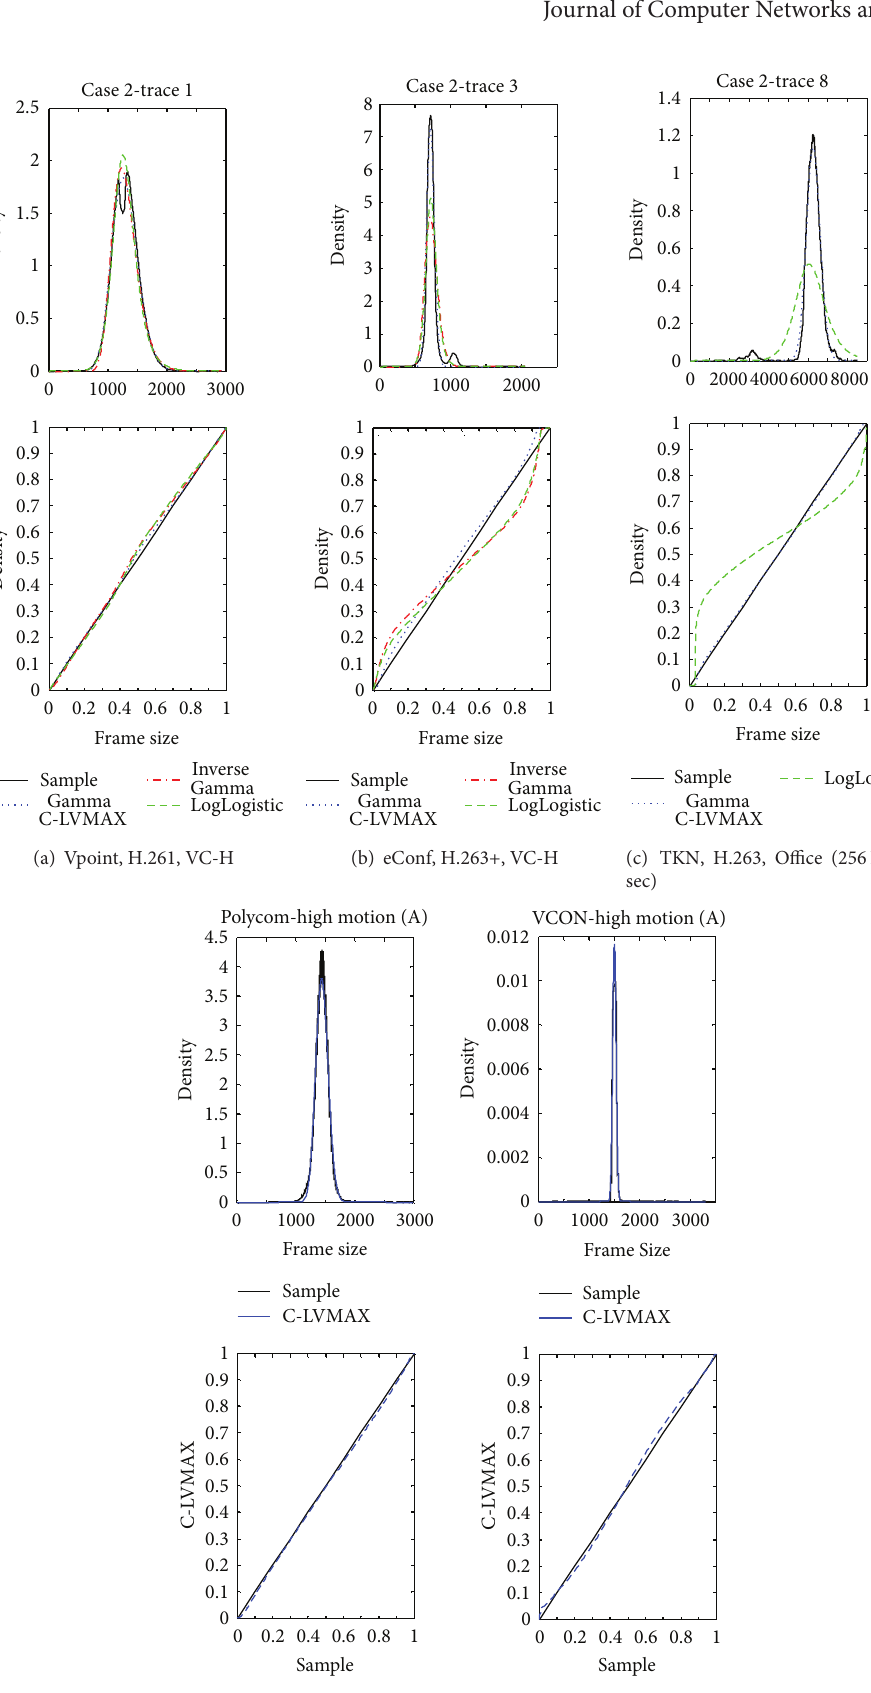
F 2: Frame-si�e �isto�rams �ersus moment and C-�V��� �t and respecti�e �-� Plots for constrained